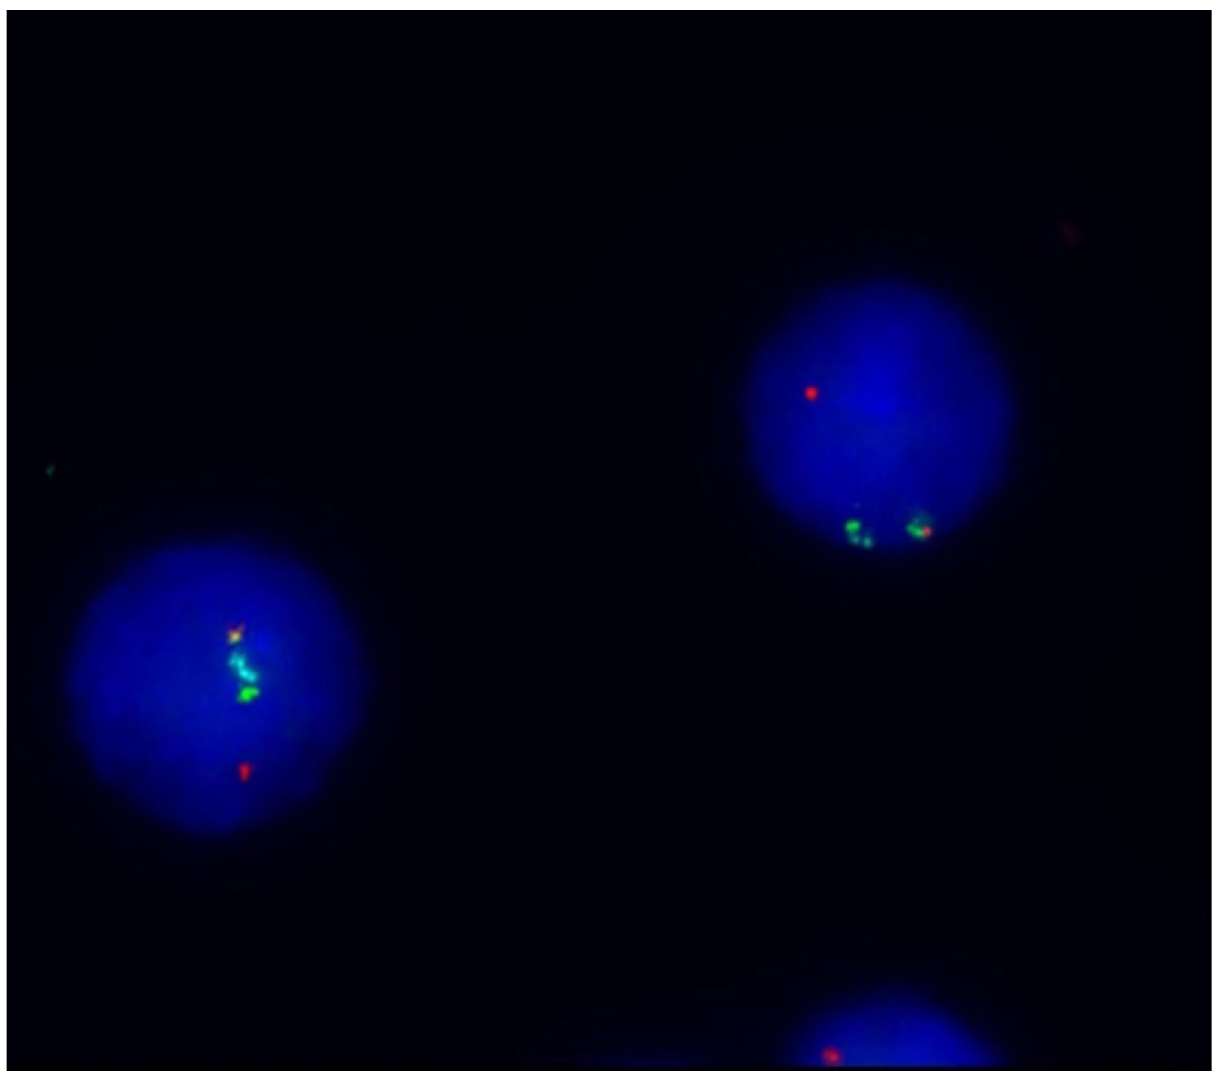
Fig. 4 FISH analysis examined by EVI1 probe mix. The red component includes the LRRC34 gene. The green component includes the centromeric part of the EVI1 (MECOM) gene. The blue component covers a 563 kb region centromeric to the EVI1 gene that includes the D3S3364 marker. EVI-1 rearrange- ment was